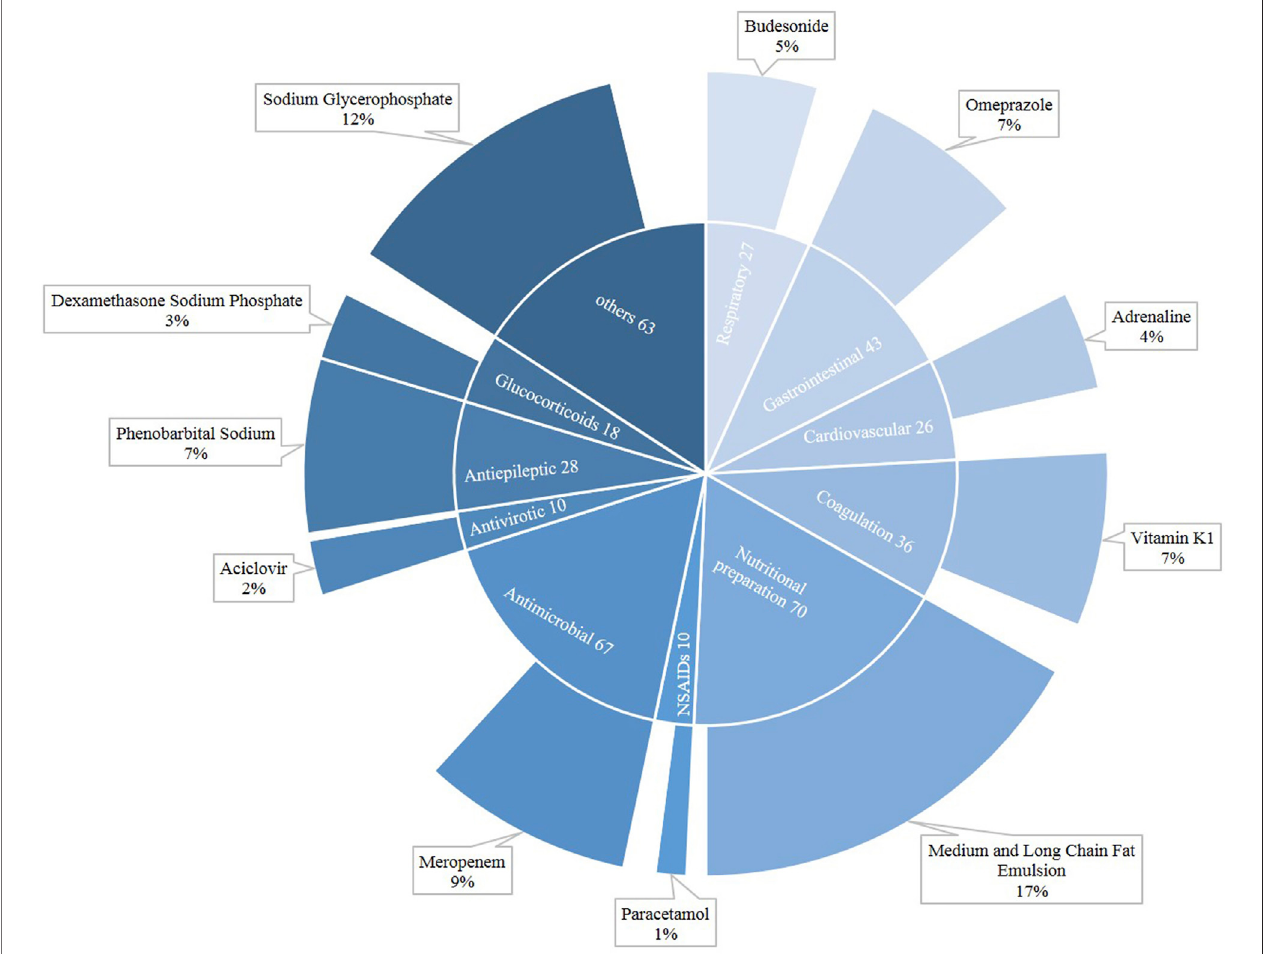
Frontiers in Pharmacology |